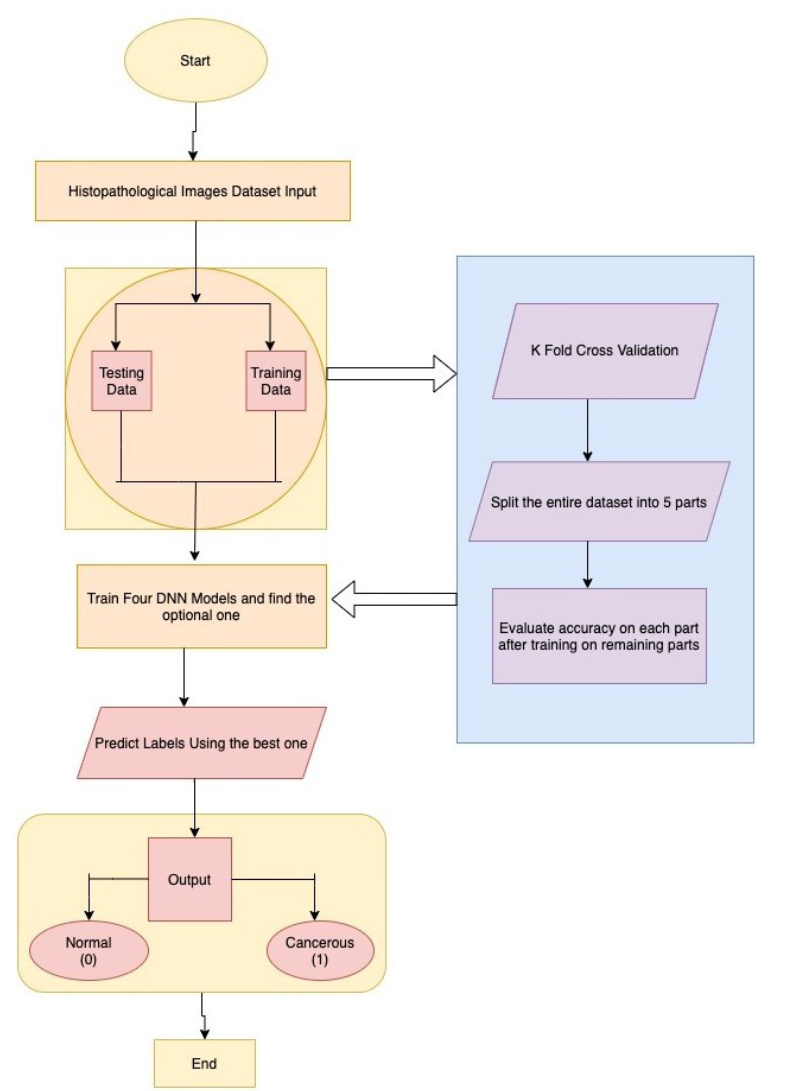
Figure 2. Model architecture and